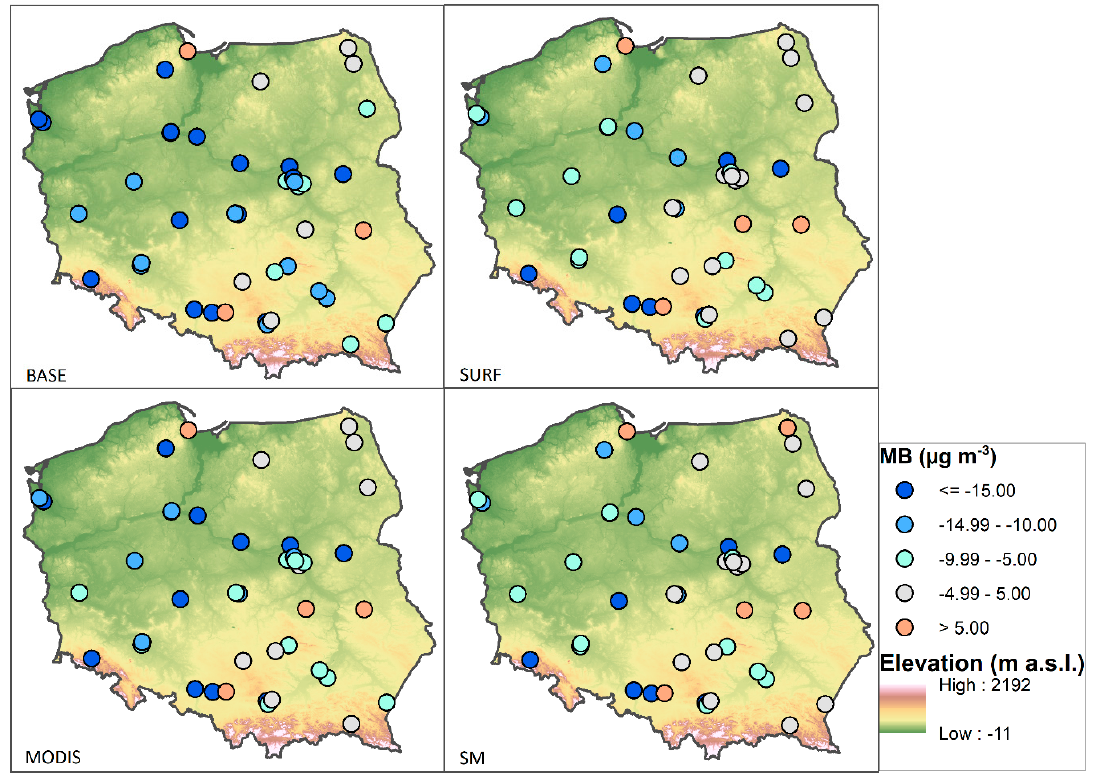
Figure 5. Spatial distributions of MB for PM2.5 concentrations for the winter 2017 episode over Poland. Elevation in meters above sea level (m a.s.l.)